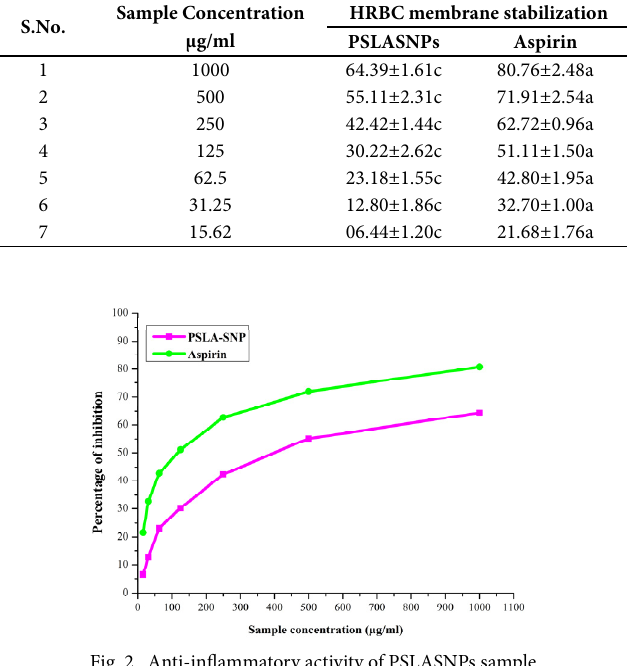
Table 3. Anti-inflammatory IC